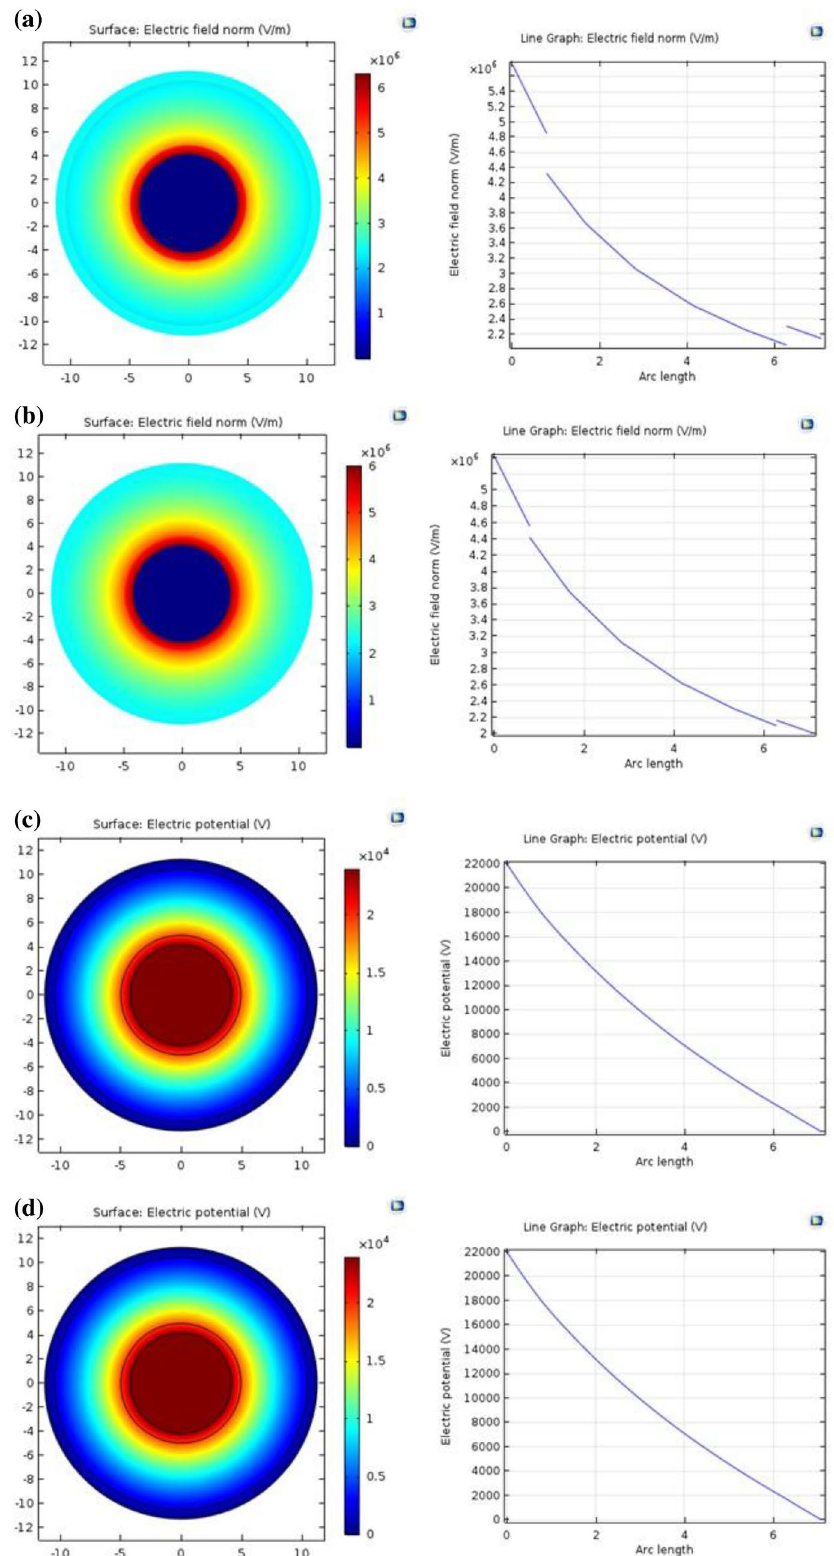
Figure 9. Electric field distribution in medium-voltage cable of ( a ) (PVC/LLDPE)ZnO-b. ( b ) (PVC/LLDPE) ZnO-pA. ( c ) (PVC/LLDPE)ZnO-b. ( d ) (PVC/LLDPE)ZnO-pA